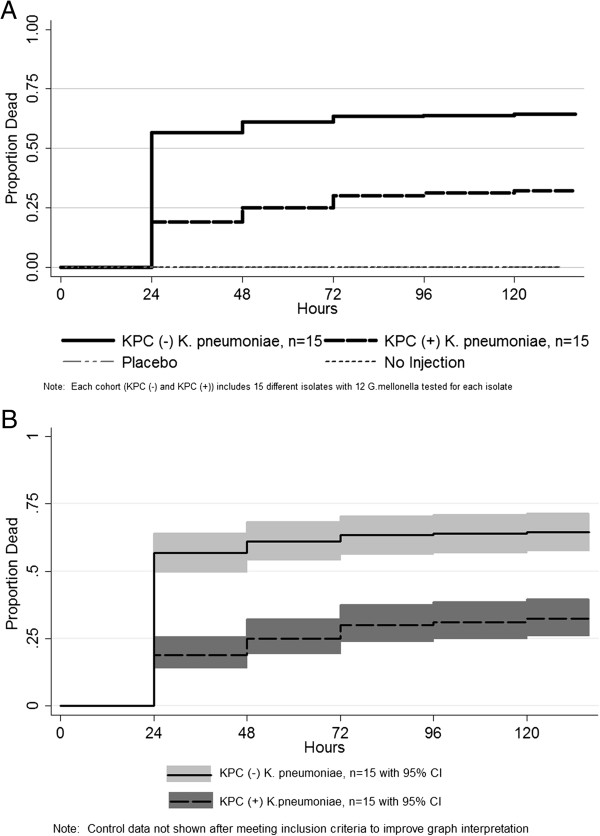
Kaplan-Meier survival for G. mellonella inoculated with K. pneumoniae isolates showing mean values (1A) and 95% confidence intervals (1B). KPC = Klebsiella pneumoniae producing carbapenemase.